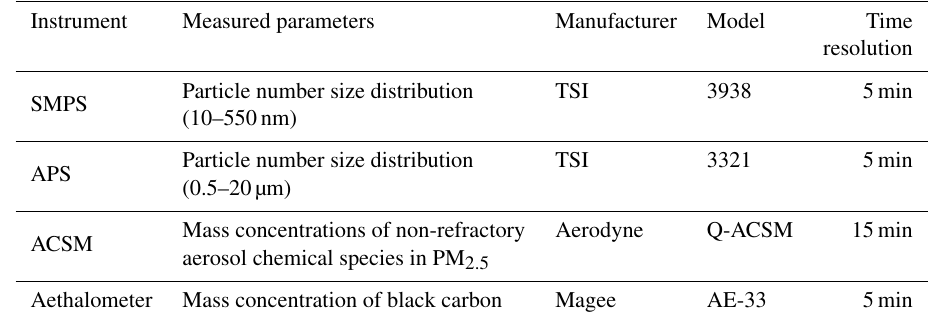
Table 1. Aerosol instruments used in this campaign and their observed parameters and manufacturer information.